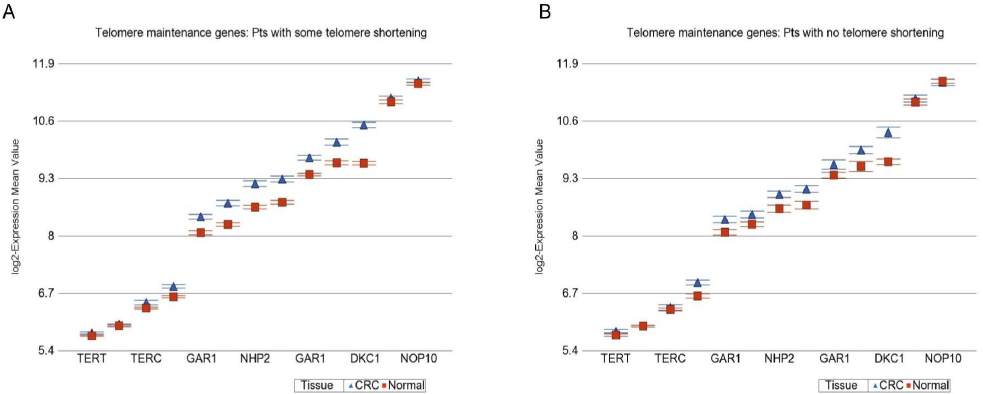
Figure 4. Differential gene expression of telomere maintenance genes in CRC tissue (in blue) com- pared to corresponding normal tissue (in red). The gene probes (multiple probes for some genes) are shown on the x-axis, and the Log2-transformed expression value is shown on the y-axis. A dif- ference of 1 on the y-axis represents a two-fold overexpression. Data from patients with RTL short- ening are shown on the left ( A ), and data from patients without RTL shortening are shown on the right ( B ). The average magnitude of overexpression was significantly higher ( p = 0.002) if the patient had telomere shortening (1.26 fold (95% CI 1.23 – 1.29)) compared to those without telomere short- ening (1.17 fold (95% CI 1.13 – 1.1.22)).